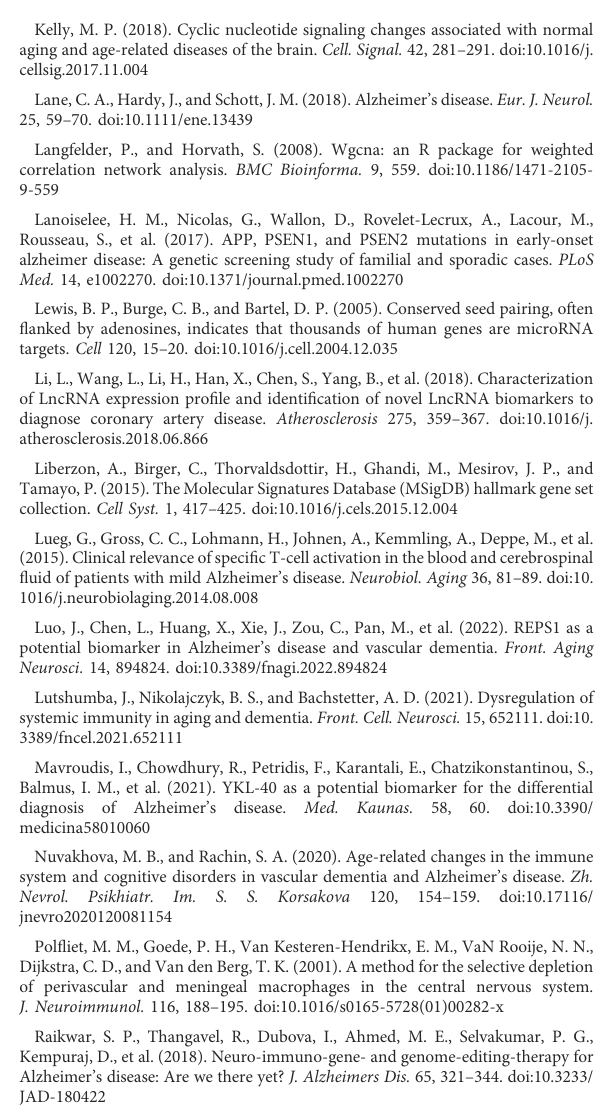
SUPPLEMENTARY TABLE S2 21 hub genes regulating KEGG